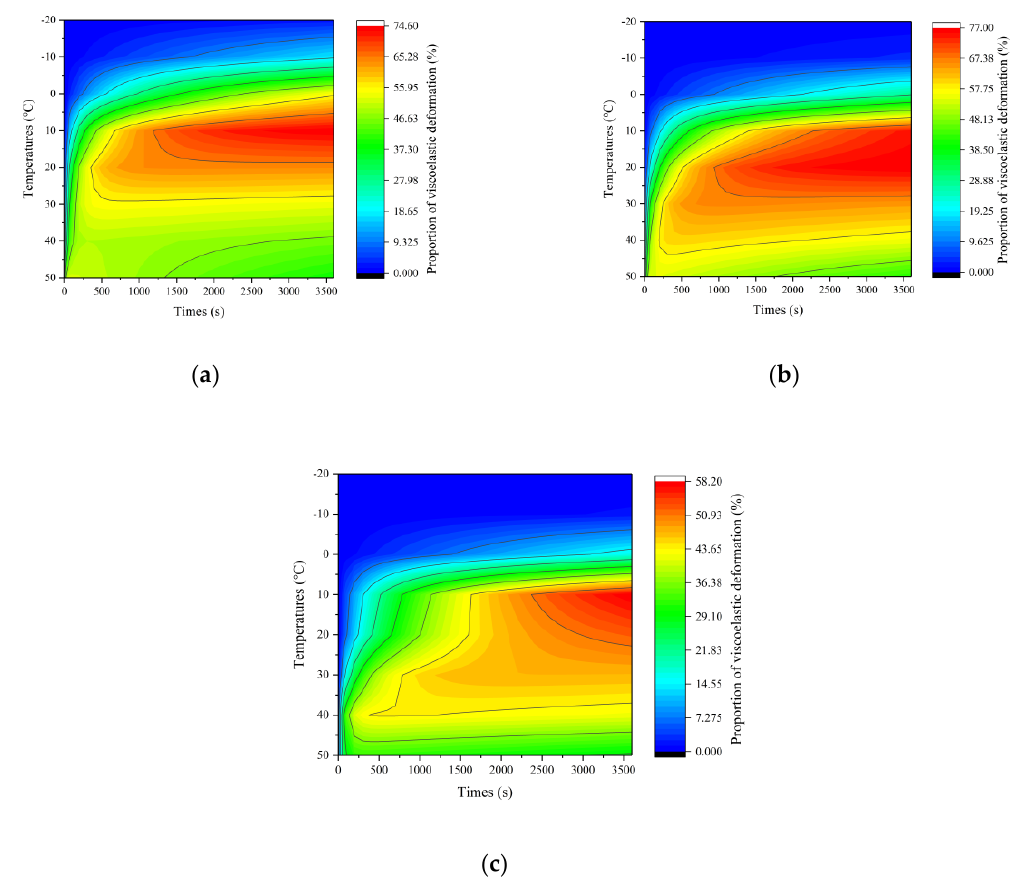
Figure 5. Proportion of viscoelastic deformation to total deformation of three asphalt mixtures: ( a ) AM; ( b ) DBFAM; ( c ) SBSAM.